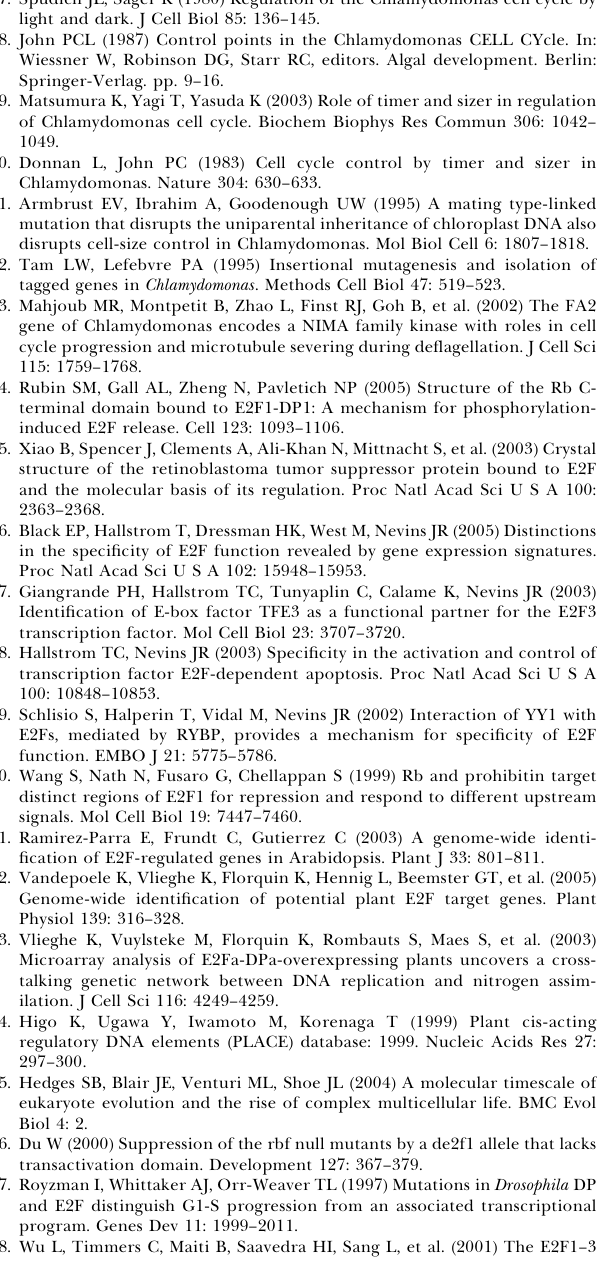
Figure S5. Expression Patterns of CYCB1, CDC6, PCN1, RIR1, MCM2, and HFO in Partially Synchronized Cultures of Wild-Type and mat3–4 Strains The samples used are the same as in Figure 8. Table S1. List of Primers for Quantitative RT-PCR Found at DOI: 10.1371/journal.pgen.0020167.st001 (21 KB